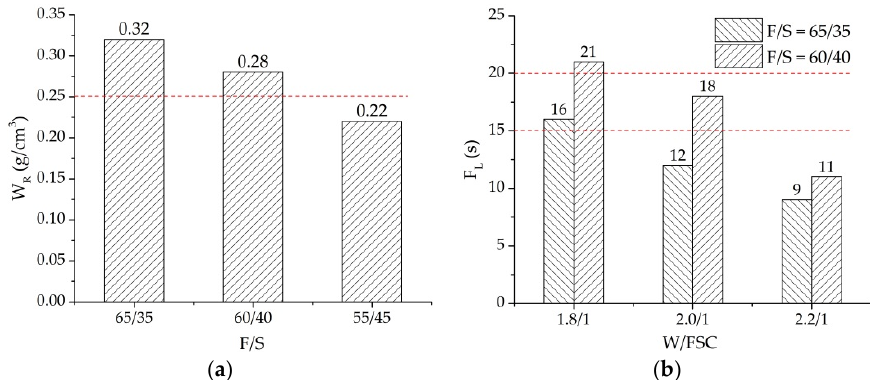
Figure 4. W R and F L : ( a ) W R under different F/S; ( b ) F L under different W/FSC.